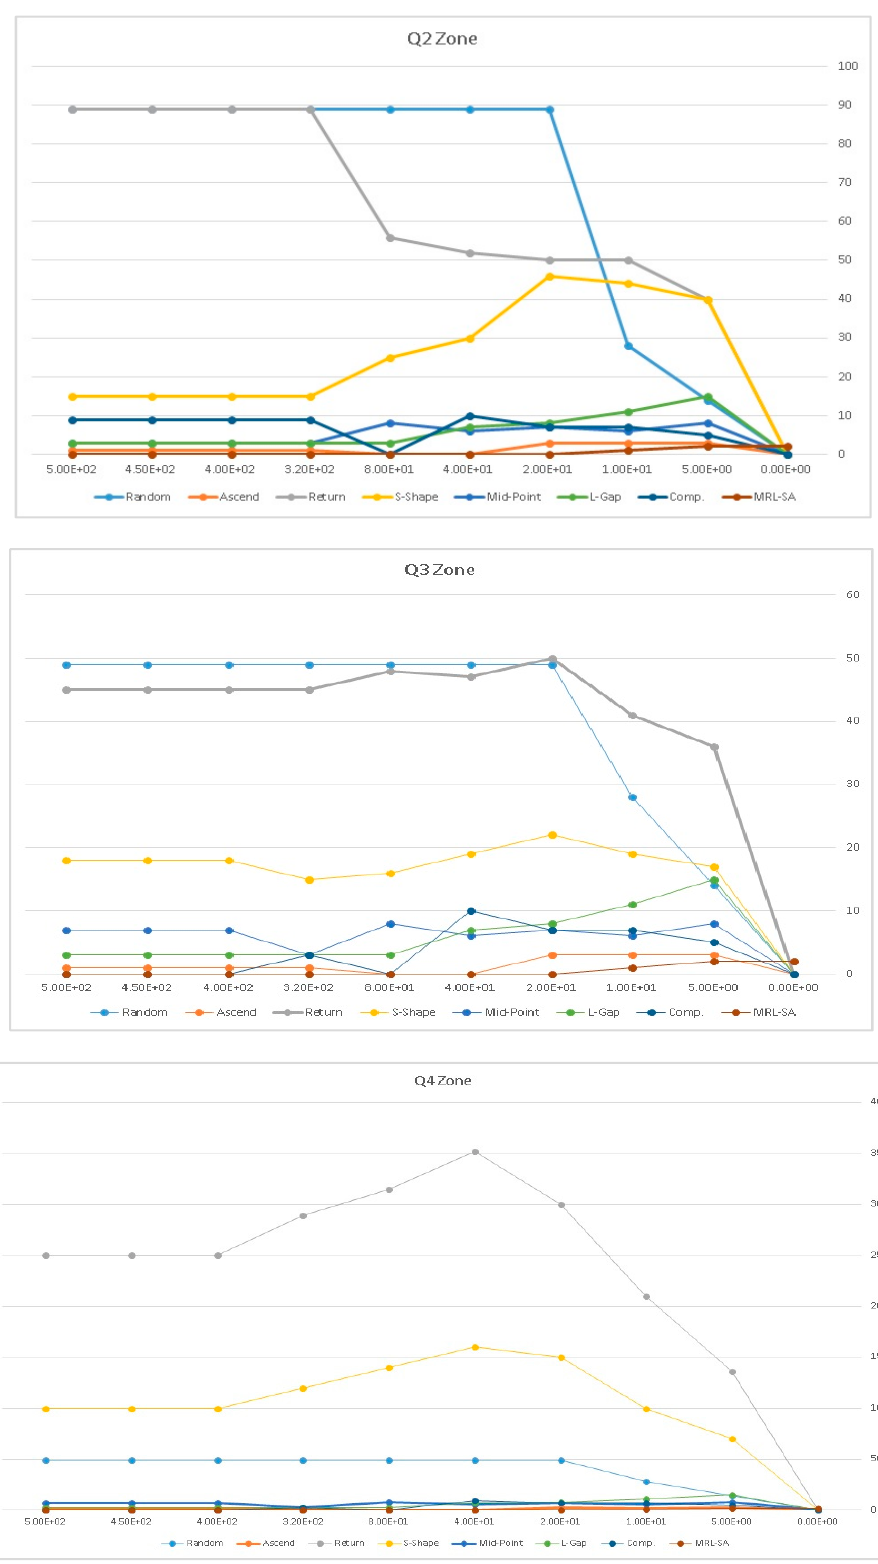
Figure 13. Comparison under horizontal classification.